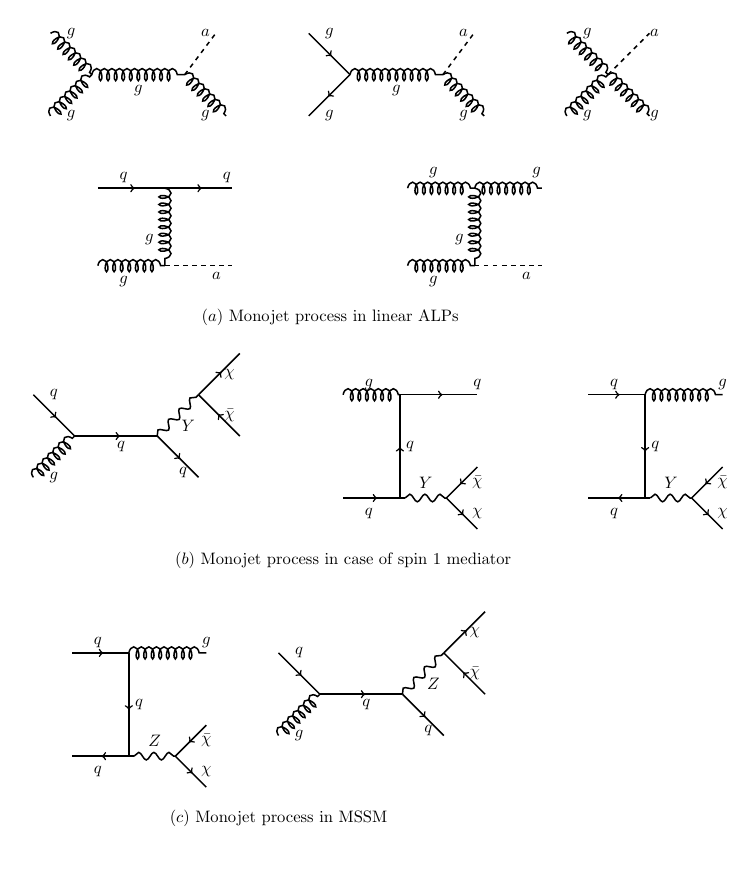
Figure 1: Feynman diagrams for monojet process in the linear ALP (top), EFT frame- work with a massive spin-1 mediator (middle) and SUSY WIMP DM cases